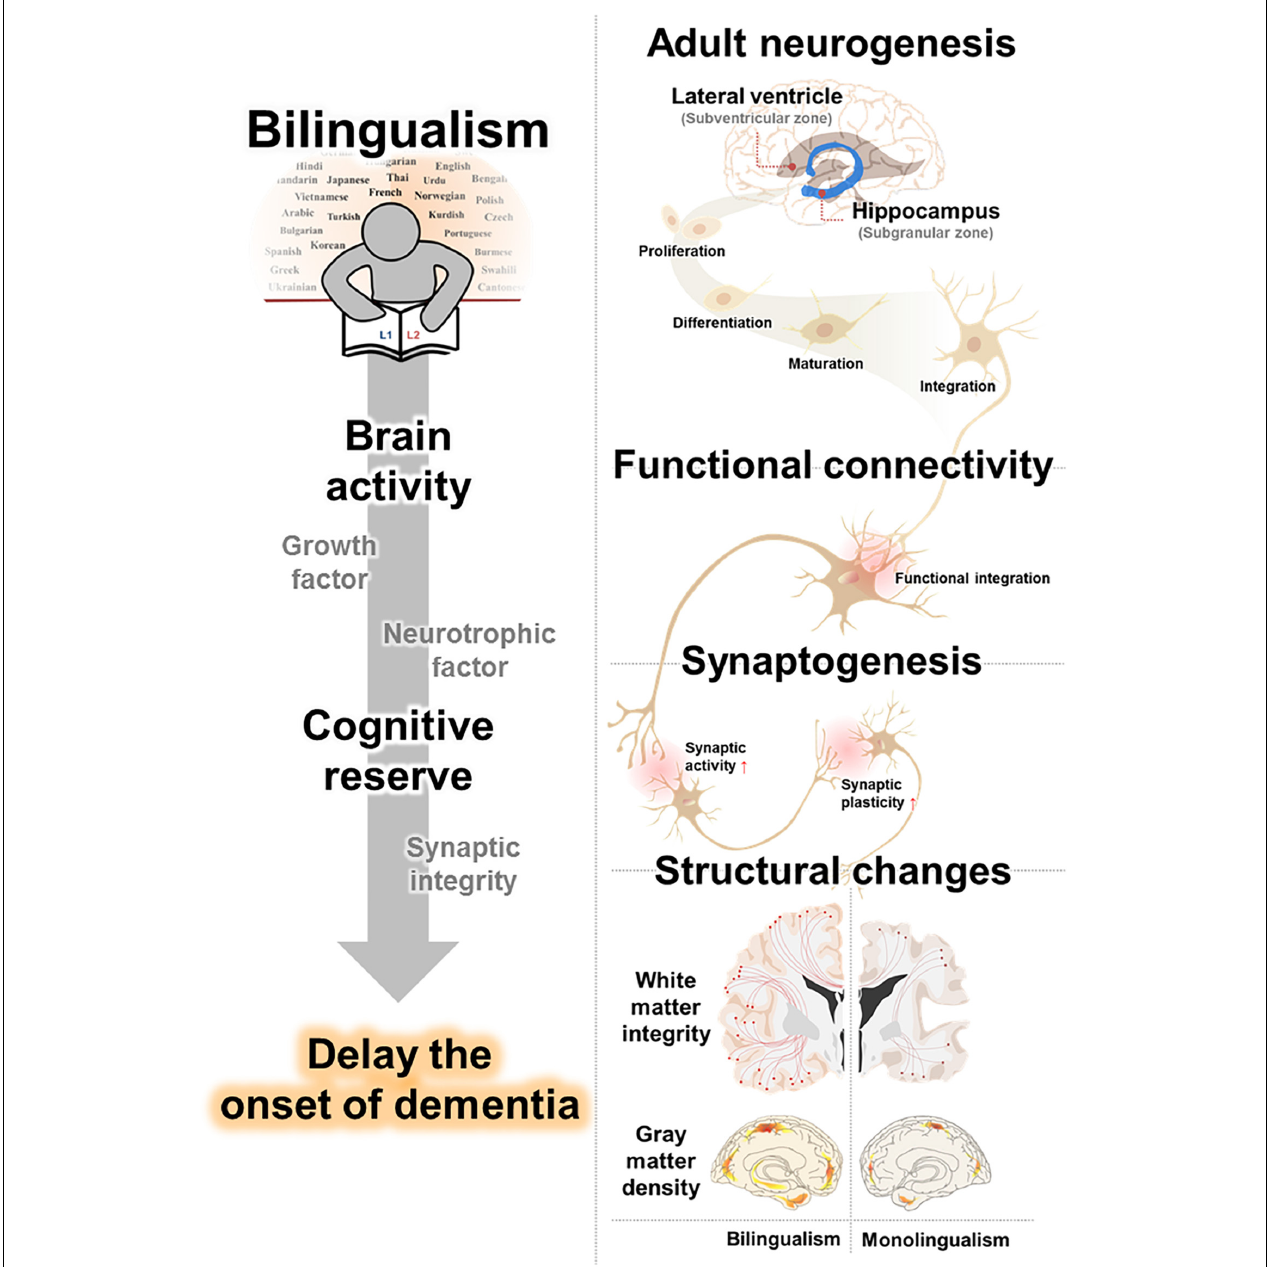
FIGURE 1 | Proposed clausal mechanisms underlying bilingualism-induced delay of dementia. Cognitive reserve from the benefits of language experience on cognitive decline is caused by an increased adult neurogenesis, strengthened synaptogenesis, and enhanced functional connectivity. Bilinguals, accompanied with changes in brain structure, including white matter integrity and gray matter density, delay the onset of